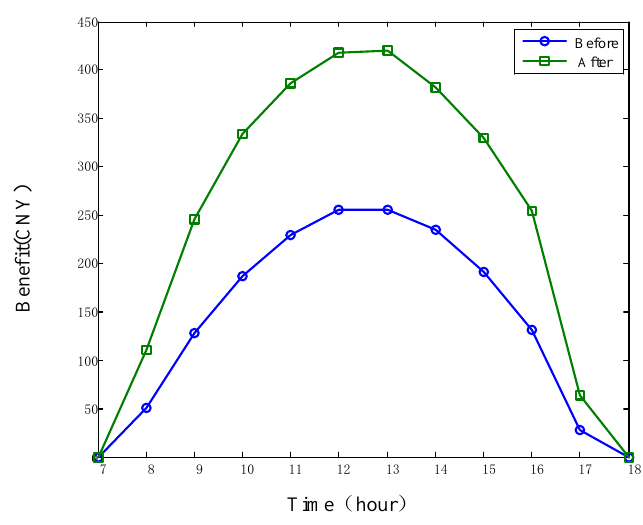
Figure 8. The comparison of the integral utilities of prosumer 1 ( a ); prosumer 2 ( b ); prosumer 3 ( c ) and prosumer 4 ( d ) before and after participating the PVC.